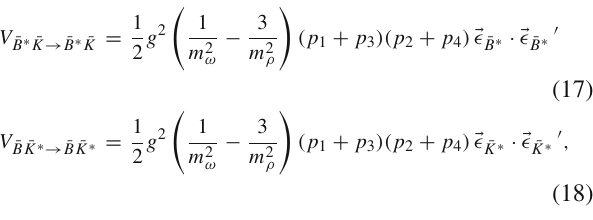
(where (cid:8) (cid:6)( (cid:8) (cid:6) (cid:6) ) is the polarization vector of the